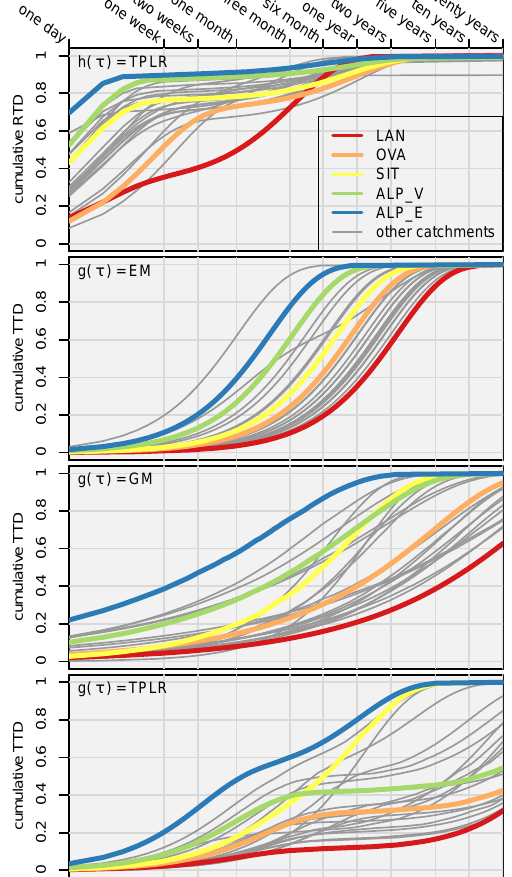
Figure 6. Top panel: cumulated response time distributions (RTDs) from the rainfall-discharge module; lower three panels: cumulated TTDs obtained by the three TF types. The shown curves are the median values of all (i.e. 30–100) accepted solutions.